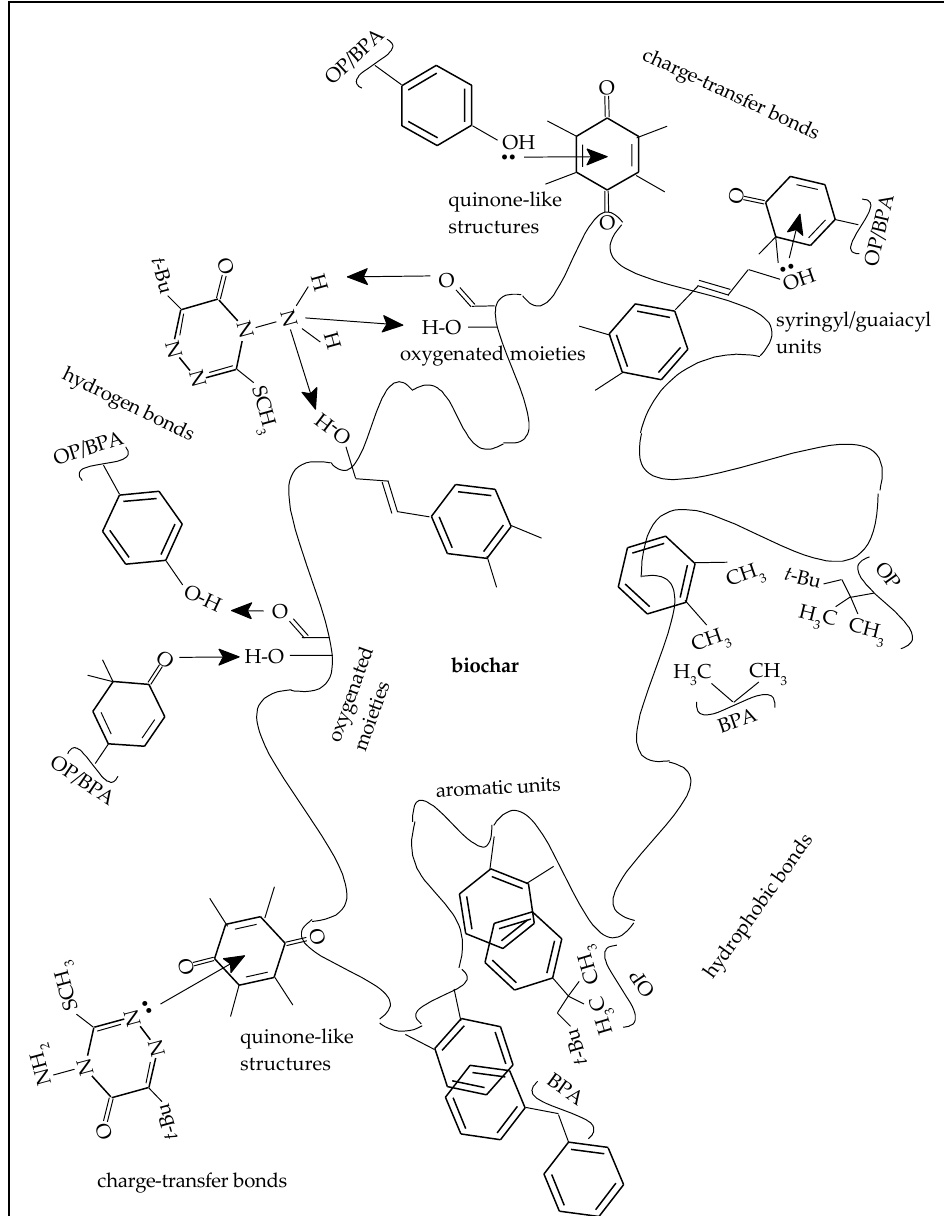
Figure 7. Adsorption mechanisms of the compounds onto biochar.